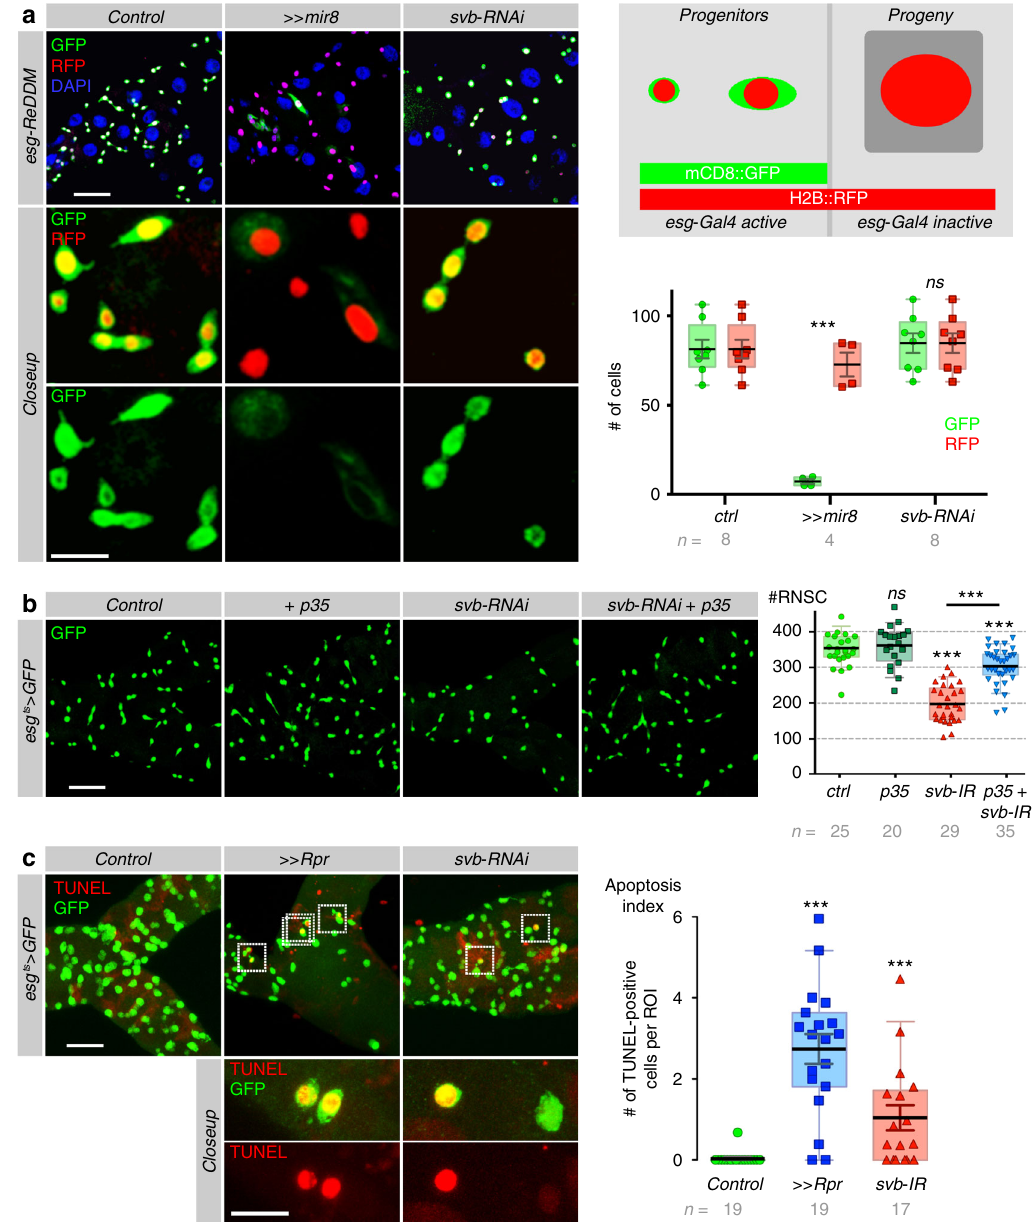
Fig. 4 svb protects RNSCs from apoptosis. a Lineage-tracing experiments ( esg -ReDDM) at 8 days after induction. While stem cells (esg-positive) express both mCD8::GFP (green) and H2B::RFP (red), only the very stable H2B::RFP protein persists in their progeny ( esg negative). Nuclei are in blue (DAPI). b Rescue of svb -depleted RNSCs by p35. esg ts was used to drive the expression of indicated transgenes (together with GFP), during 8 days. Quanti fi cation of esg + cells is shown at the right. Ctrl vs p35 ( p = 0.6613), svb-RNAi ( p < 0.0001), p35 + svb-RNAi ( p = 0.0006), svb-RNAi vs p35 + svb-RNAi ( p < 0.0001). c TUNEL assays (red) revealing the increase in RNSC apoptosis upon expression of the pro-apoptotic gene reaper ( Rpr, p < 0.0001), or RNAi depletion of svb ( p = 0.0002), driven by esg ts > GFP (green). Renal stem cells undergoing apoptosis (green cytoplasm and red nuclei) are boxed, and better seen in closeups. The apoptotic index was calculated as the number of TUNEL-positive cells/GFP-positive cells (×100). Values are presented as average ± standard error of the mean (SEM) and boxes with whiskers (10 – 90 percentile). p -Values are calculated using Mann – Whitney test (*** p < 0.001). n = number of observed tubules. Scale bar is 30 µ m, except in closeup panels (10 µ